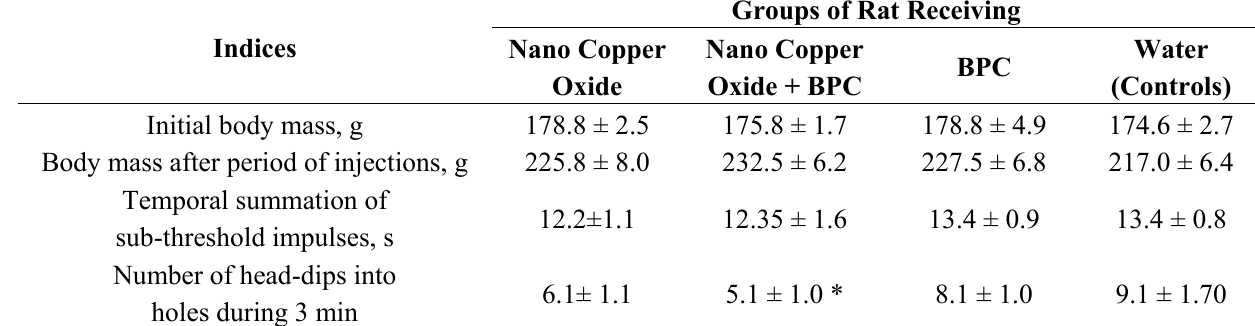
Table 4. Indices for the status of the organism of rats after repeat intraperitoneal injections of copper oxide nano-suspensions and/or oral administration of the bioprotective complex (BPC) ( х ± S х